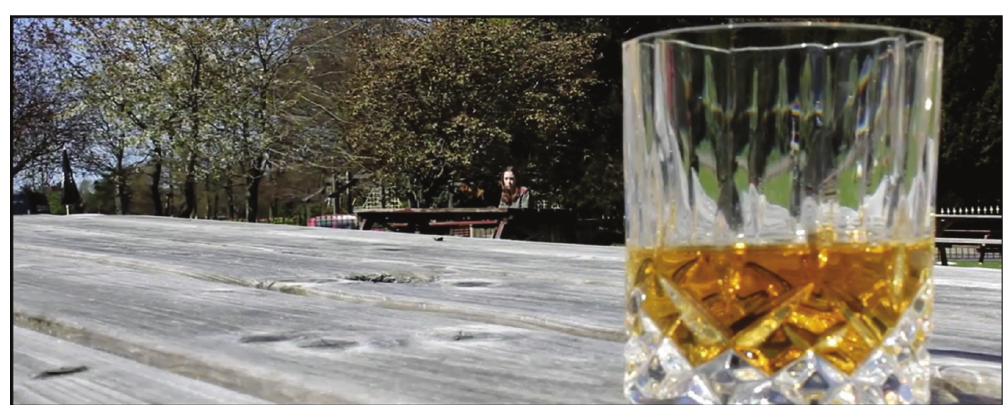
Figure 1: Still from Open Arms , Birkenhead Sixth Form College students, 2015: exploring l’intervalle